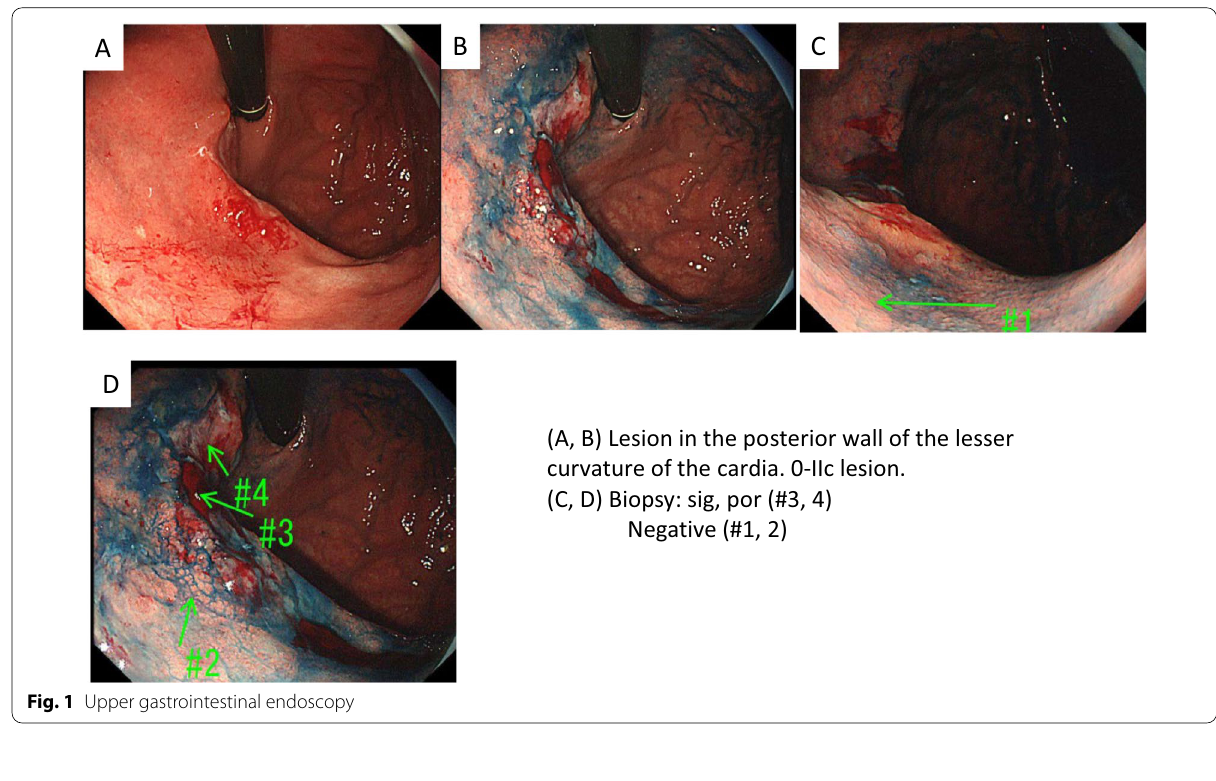
Fig. 1 Upper gastrointestinal endoscopy